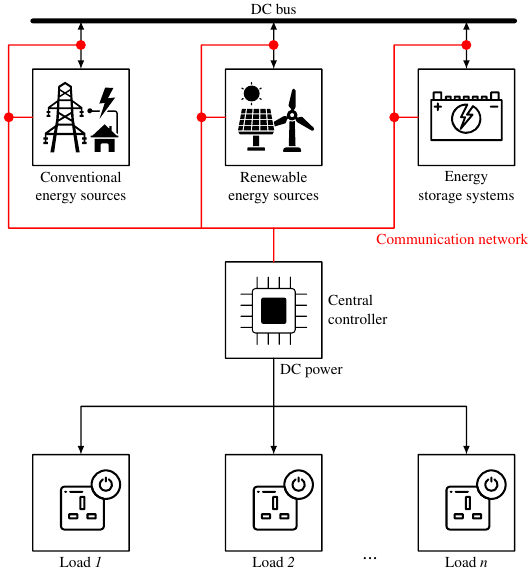
Figure 3. Central nanogrid controller.